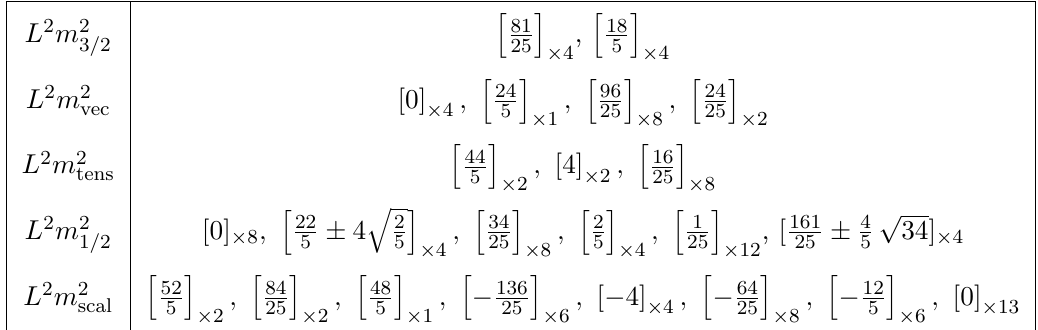
Table 12 . Masses for the AdS vacuum A5.